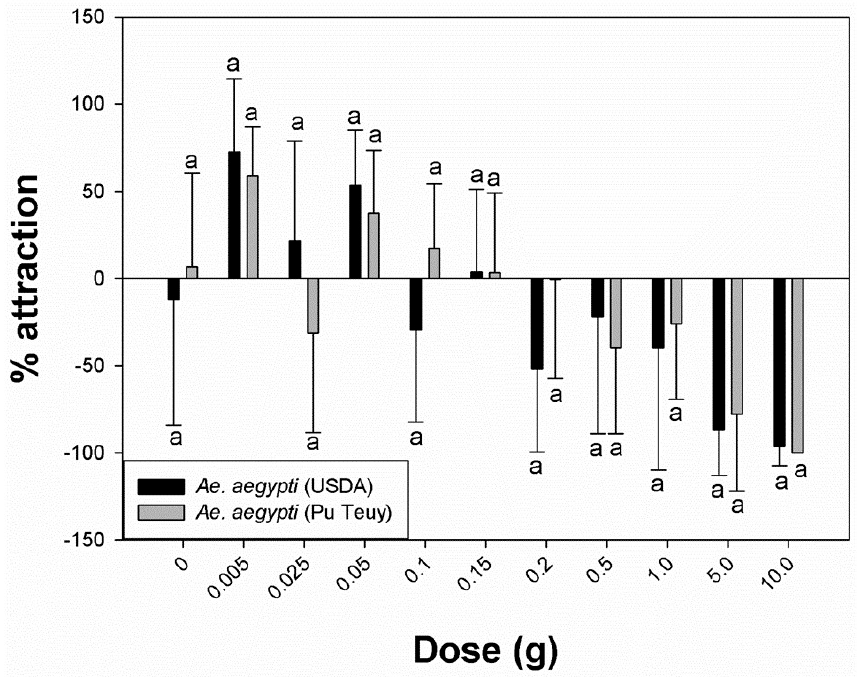
Figure 2. Percentage attraction within species, Aedes aegypti USDA (susceptible) and Pu Teuy (resistant) mosquitoes. Different letters between USDA and Pu Teuy indicate statistical significance (Mann–Whitney U test, p < 0.05).